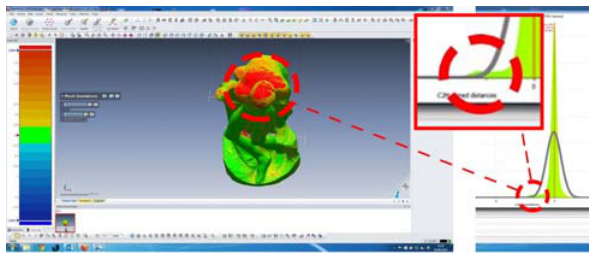
Figure 7. On the left: the red area highlights a shift between models on the back of the statue. On the right: this behaviour is shown from the left tail of the Gaussian distribution.